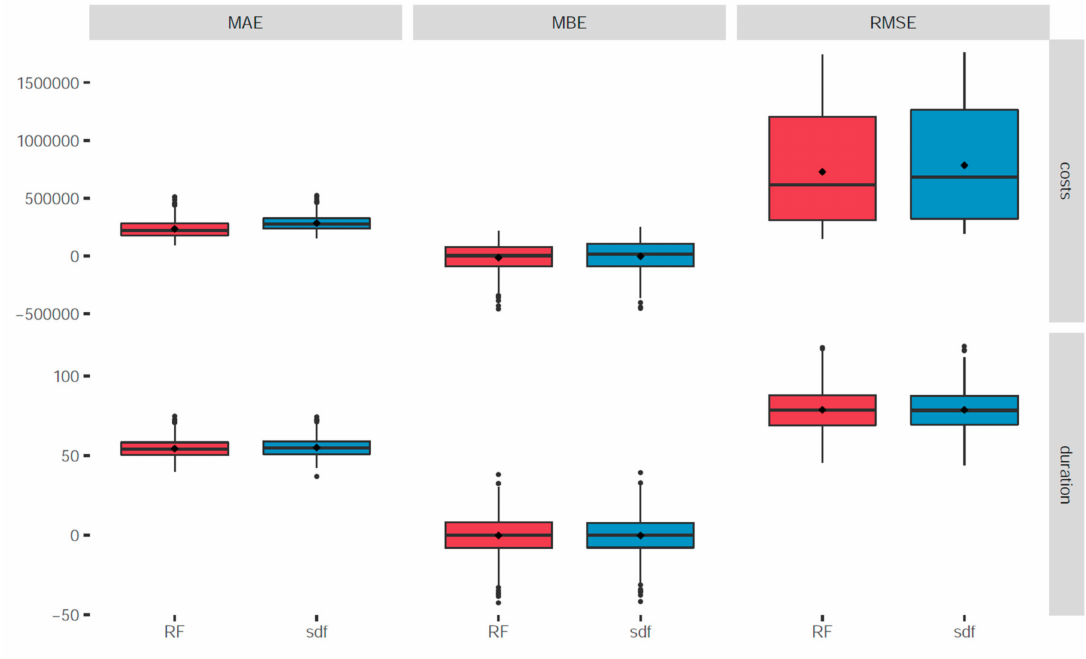
Figure 7. Error comparison of the Random Forest model and the stage damage